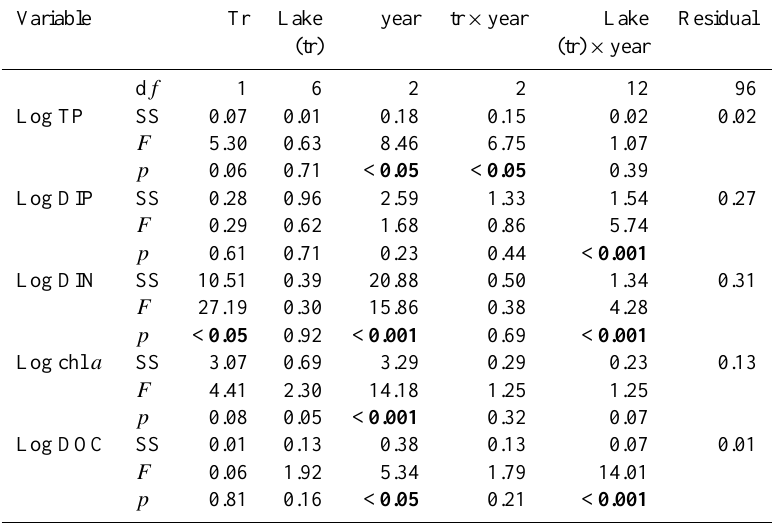
Table 3. Results of the three-way ANOVA testing the effect of treatment (tr : perturbed, unperturbed), lake, year and their interactions on TP, DIP, DIN, chl a and DOC. Variables were transformed to achieve normality and homogeneity of variance. The principal source of variation of interest is the interaction between the treatment and the year of sampling. Significant p values ( p < 0 . 05) are in bold. Variable Tr Lake